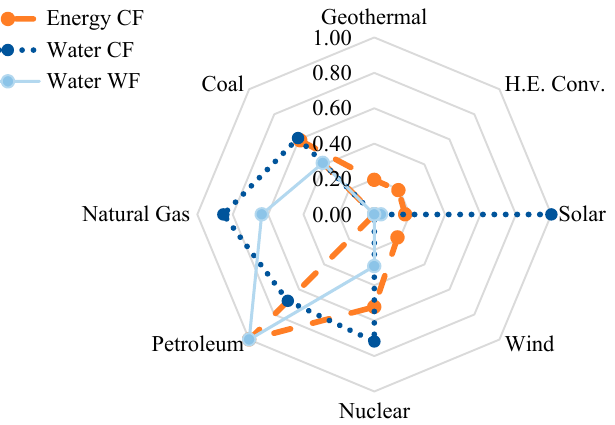
Figure 3. Scaled rates of energy consumption footprint (CF, MMBtu/MWh), water CF (Mm 3 /MWh) and water withdrawal footprint (WF, Mm 3 /MWh). Solar includes only thermal as PV systems do not report water use. Biomass and Other energies are not included due to their mixed fuel source.